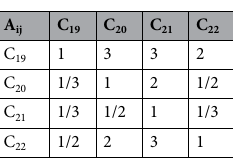
Table 7. Comparative criteria level matrix (Level 2